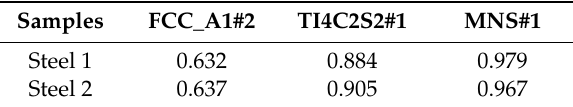
Table 5. Solid fraction of precipitated phases.